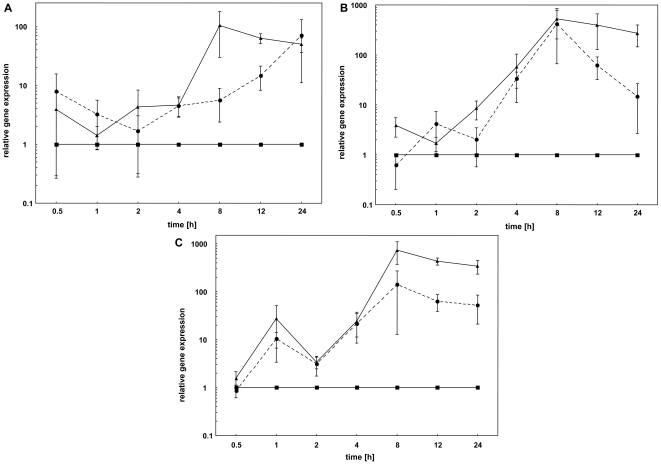
Antimicrobial peptide gene expression within 24 hours post-treatment.Gene expression pattern of abaecin (A), defensin 1 (B) and hymenoptaecin (C) in bumble bee workers within 24 hours, after injection of bee ringer (filled circles, dashed line) and E. coli (triangles, solid line). At each time point plots represent the median, minimum and maximum on gene expression of three workers (log-scaled, note different scales in these plots). Values for different graphs were calculated by the relation of gene expression in context to the expression level of ‘control treated’ bumble bees (squares, solid line).